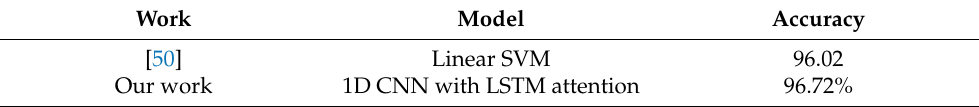
Table 8. Performance comparison of the works in the ANAD